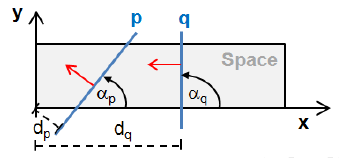
Figure 1. Rule parameters of a